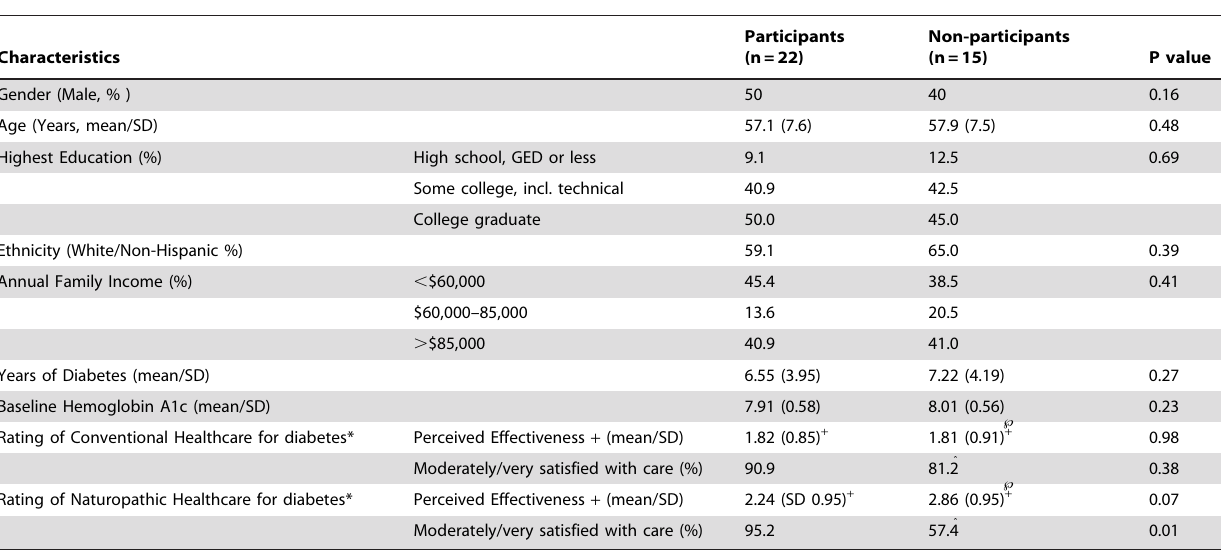
Table 1. Demographics of participants and